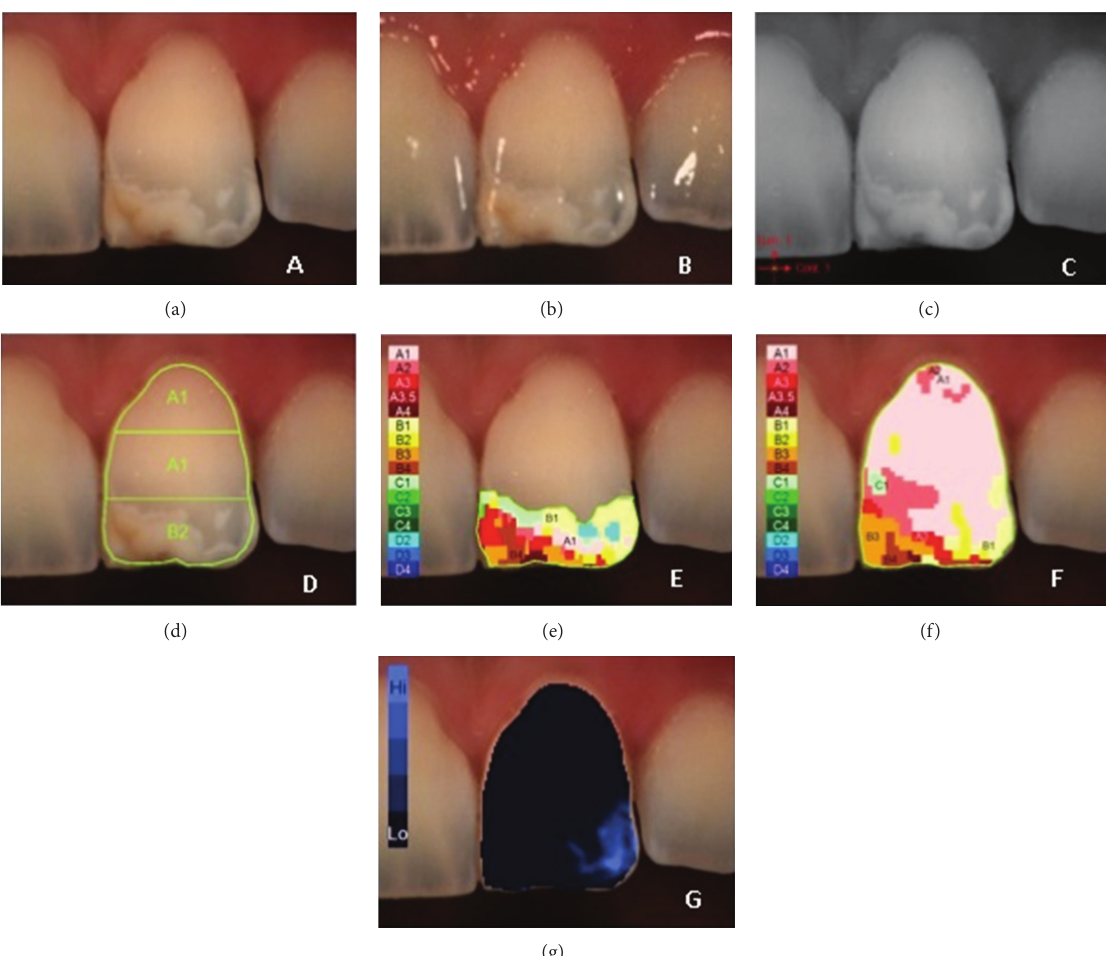
Figure 1: Example of 𝐿 ∗ 𝑎 ∗ 𝑏 ∗ measurements of demarcated opacity: (a) polarized image; (b) gloss mode allowing the identification of “pure enamel zones”; (c) contrast image; (d) evaluation of the three equal zones along the median axis: gingival, central, and incisal; (e) colour distribution and detailed mapping of the defect surface; (f) overall detailed mapping; (g)